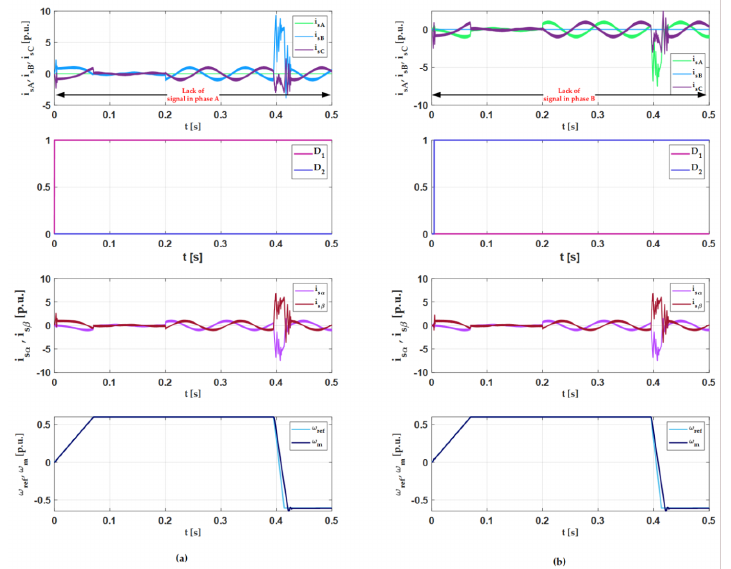
Figure 17. Transients of basic variables under start-up with lack of signal and its compensation in phase A ( a ) and B ( b ) respectively phase currents, detector responses, current components α , β and